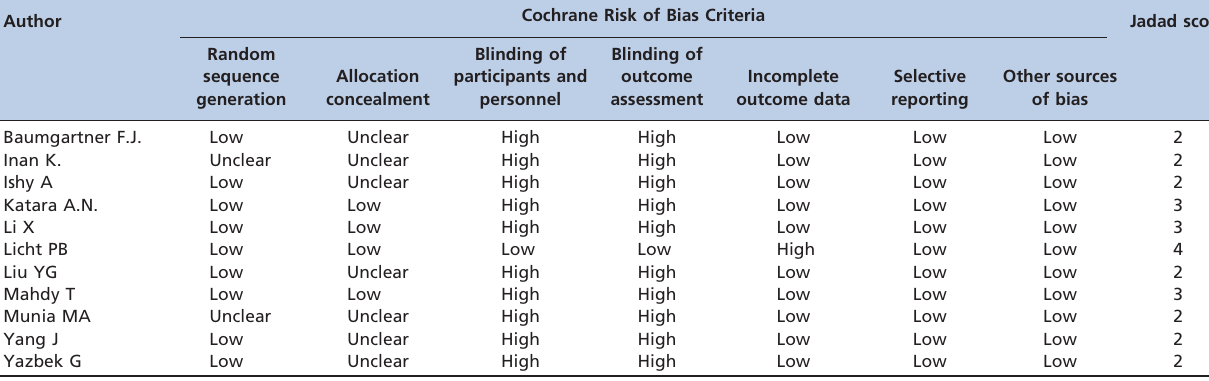
Table 2 - Risk of Bias.